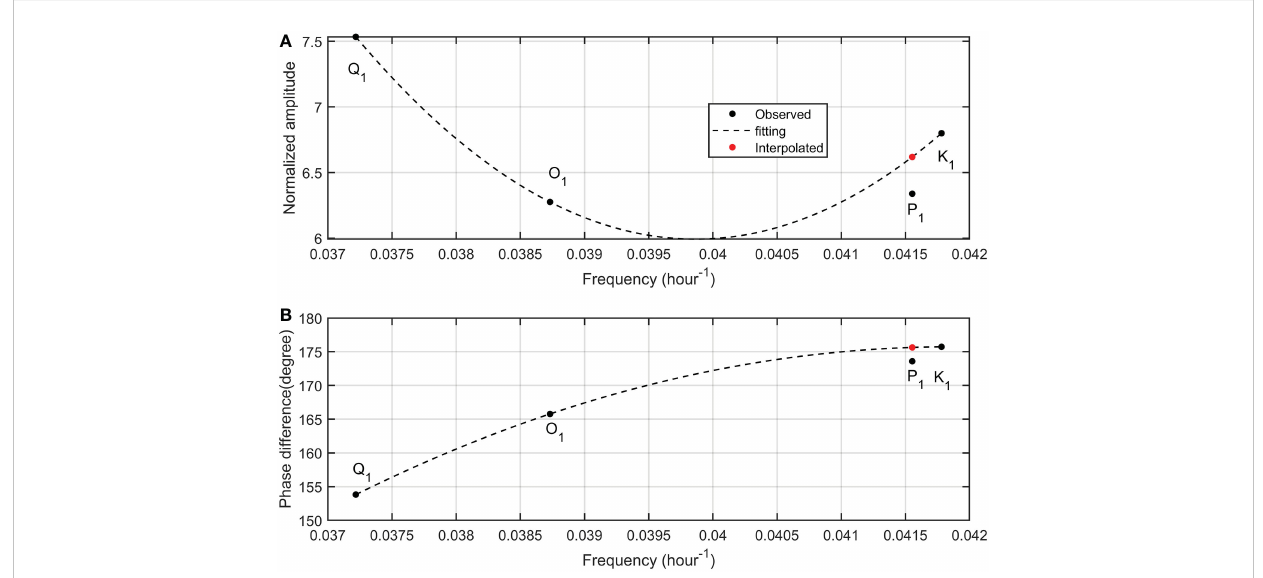
FIGURE 9 Same as Figure 4, but for surface tides at the mooring. Tidal constants are derived from EOT20